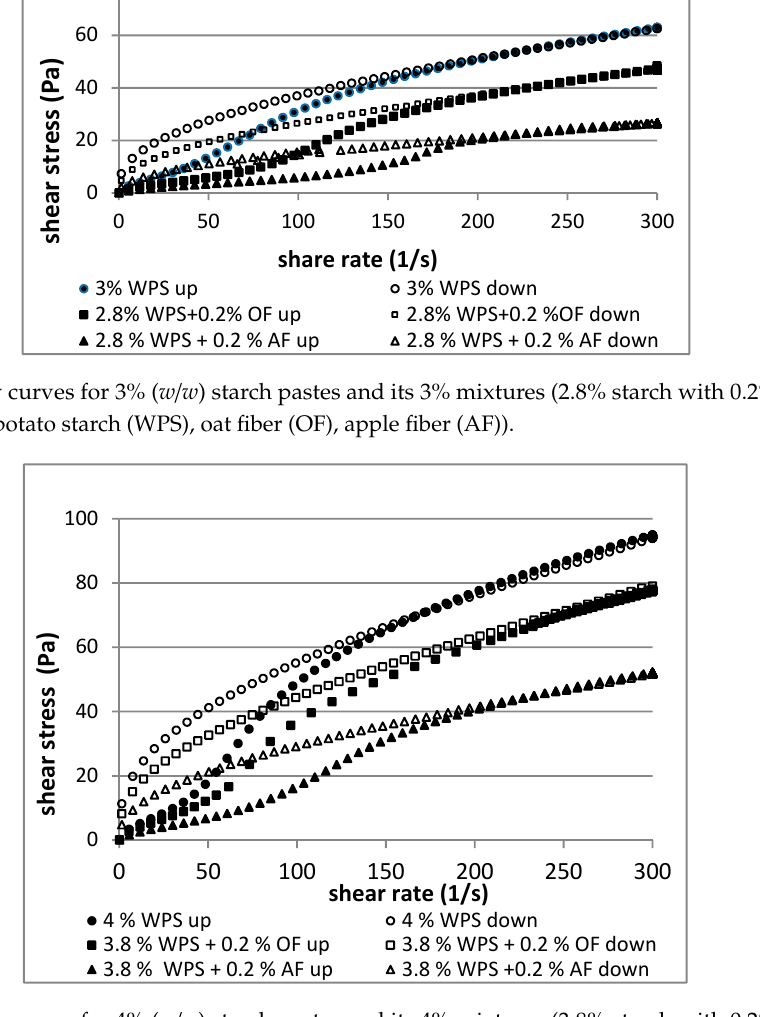
Figure 4. Flow curves for 4% ( w / w ) starch pastes and its 4% mixtures (3.8% starch with 0.2% dietary fibers) (Waxy potato starch (WPS), oat fiber (OF), apple fiber